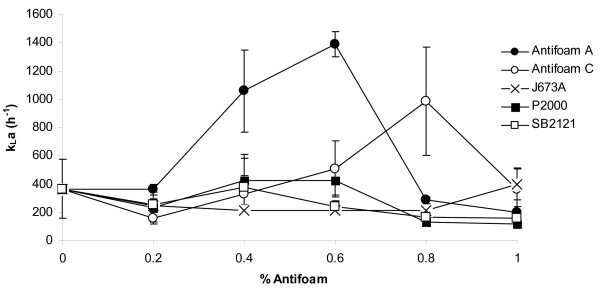
kLa data for the antifoam panel. The antifoams used in Figure 1, were tested to examine how their addition affected kLa. Values were recorded for 0-1% v/v antifoam for Antifoam A (closed circles), Antifoam C (open circles), J673A (crosses), P2000 (closed squares) and SB2121 (open squares).